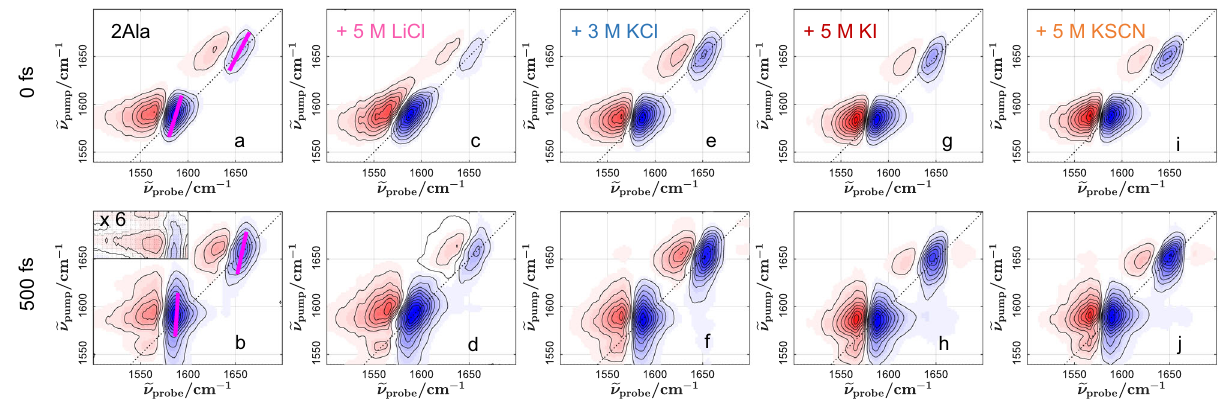
Fig. 7 2D-IR spectra of 2Ala + salt to reveal the ion-speci fi c vibrational structure and spectral dynamics. 2D-IR spectra of 0.25 M 2Ala in D 2 O ( a , b ) in the absence of salt, with 5 M LiCl ( c , d ), with 3 M KCl ( e , f ), with 5 M KI ( g , h ) and 5 M KSCN ( i , j ). Top panels show spectra at 0 fs waiting time. With increasing waiting time, vibrational relaxation results in a decay of the signals, leading to a variation of the relative intensities of both diagonal peaks at a waiting time of 500 fs (bottom panels). The dotted black lines indicate the diagonal line. The inset in ( b ) shows a zoom into the region where the cross- peak is detected. Pink lines in ( a , b ) represent the center line slope used to quantify frequency – frequency correlations.